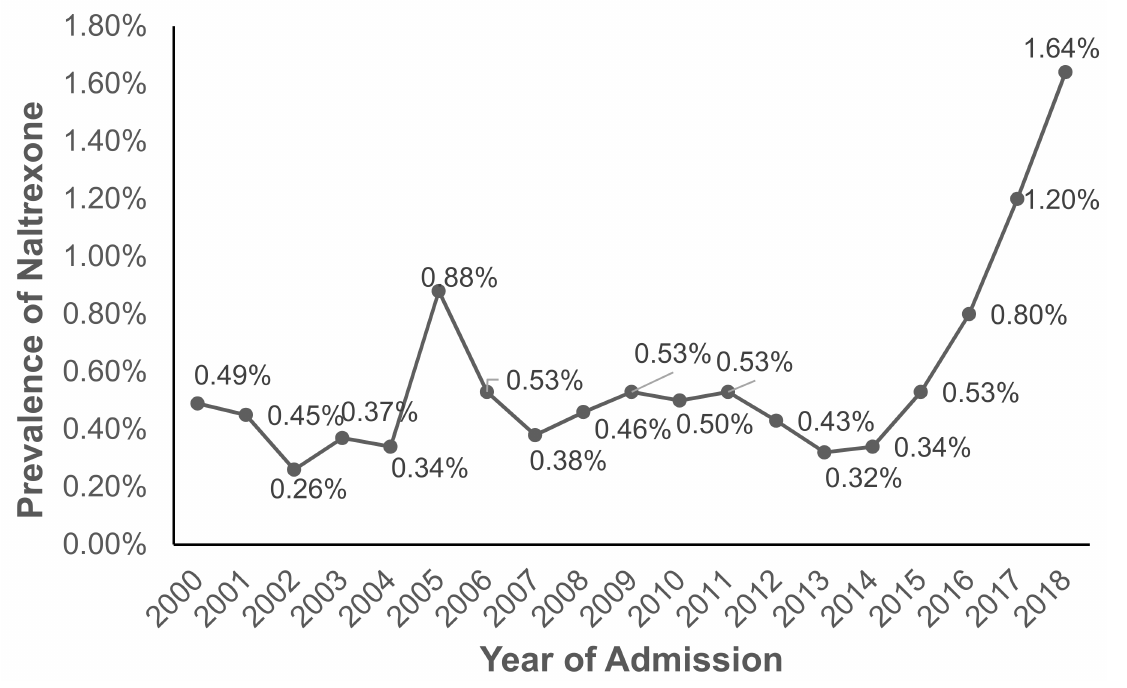
Figure 1. Prevalence of naltrexone treatment prescribed in alcohol use disorder (AUD) admissions from 2000–2018 using TEDS-A data. Temporal trends were significant by the Cochran–Armitage trend test ( Z = − 57.3, p < 0.0001).